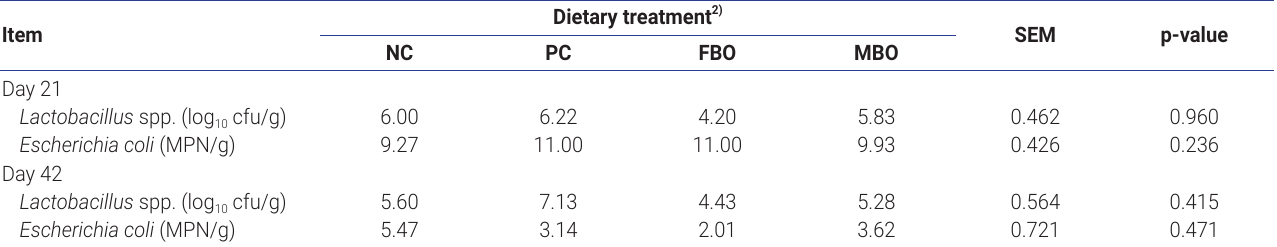
Table 6. Lactobacillus spp. and Escherichia coli populations in ceco-colon of broiler chickens on day 21 and day 42